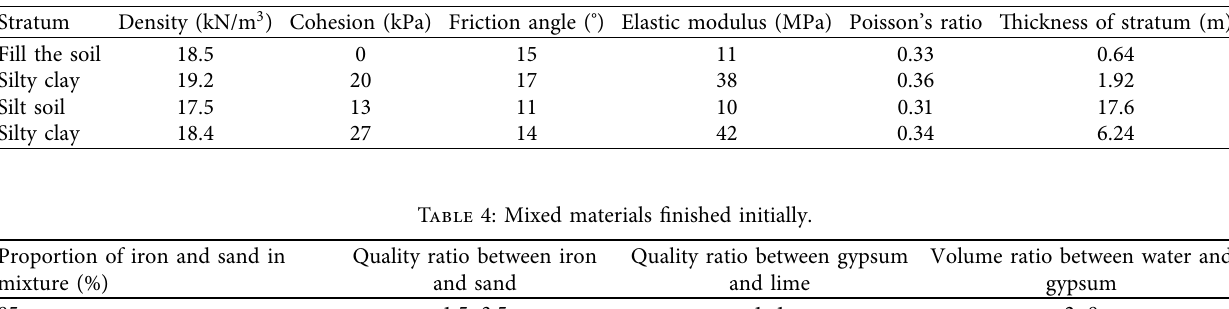
Table 3: The physical quantity of prototype stratum in Shanghai.